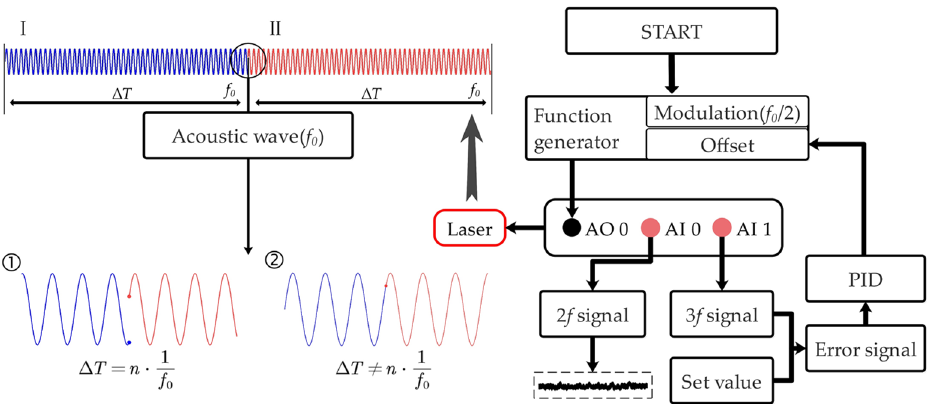
Figure 2. Right part: Flow chart for line-locked process based on a LabVIEW platform. Offset: a preset bias current corresponding to a wavelength near the absorption line; f 0 : resonant frequency of the custom QTF. Left part: Feedback interval Δ T should be selected as an integer multiple of the QTF oscillation period, thus phase matching between successive modulation periods I and II can be maintained for continuous measurement without counteraction.